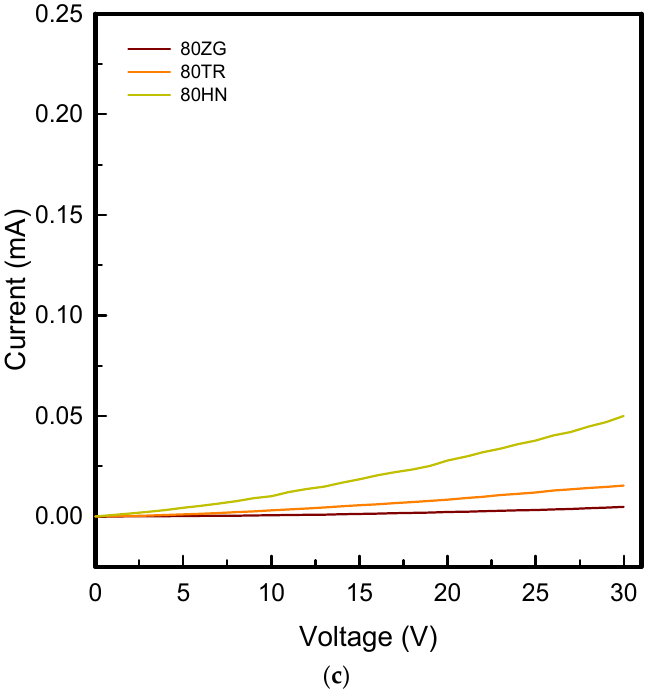
Figure 6. The current-voltage (I-V) curves of coated 3DP index fingertips with 8 wt% GR/WPU composite solution under various infill patterns and densities: ( a ) 20% infill density; ( b ) 50% infill density; ( c ) 80% infill density.